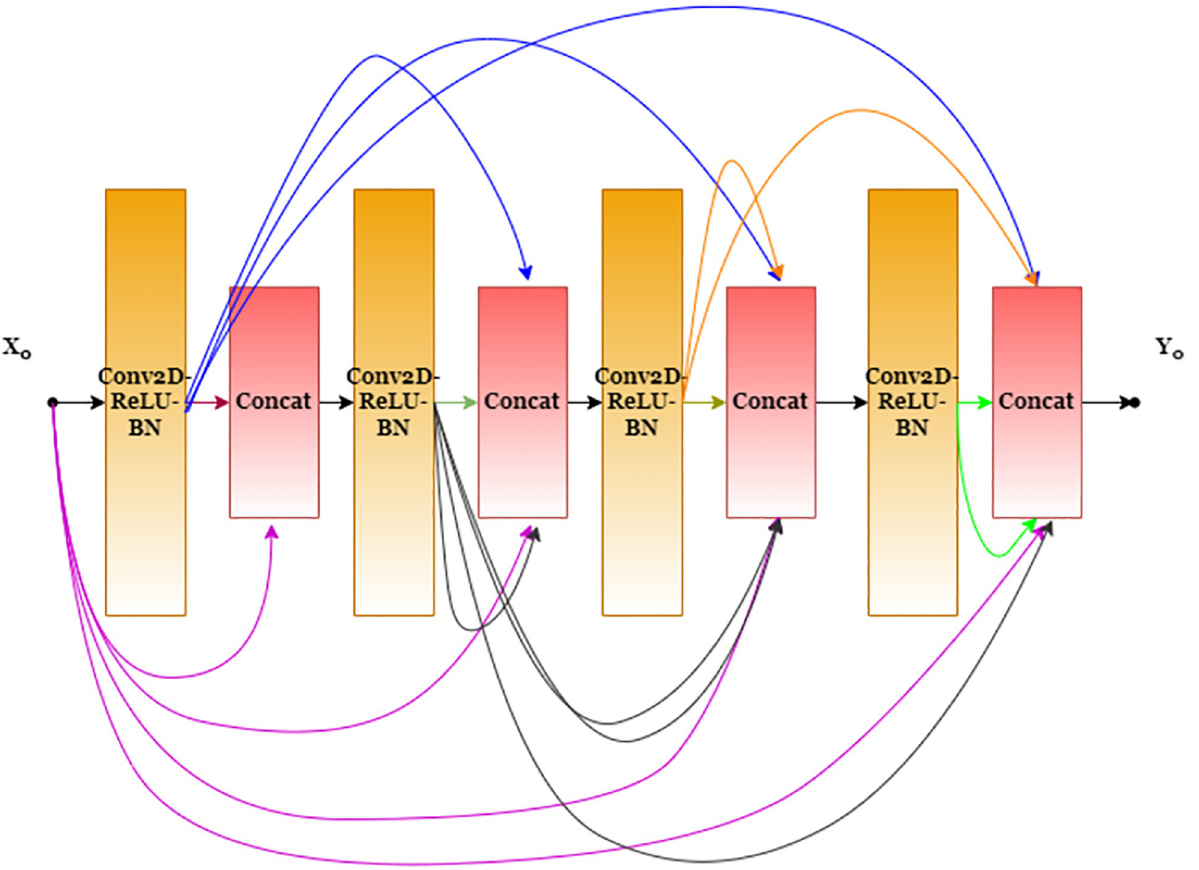
Fig 4. A basic block used in the DenseNet architecture. Modified from Huang et al.